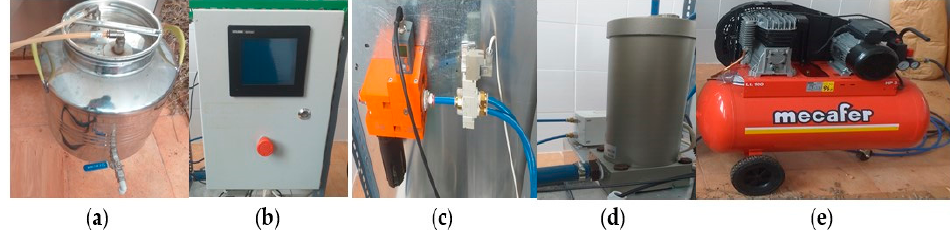
Figure 6. The main subassemblies of the experimental equipment for the extraction of bioactive compounds: ( a ) control panel, ( b ) recirculation pump, ( c ) recirculation pump, ( d ) hydro-pneumatic cylinder, ( e )